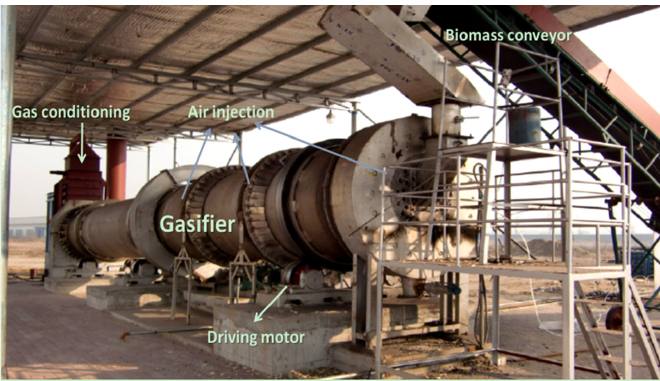
Figure 3. A view of the1.5 MW th biomass gasification system.